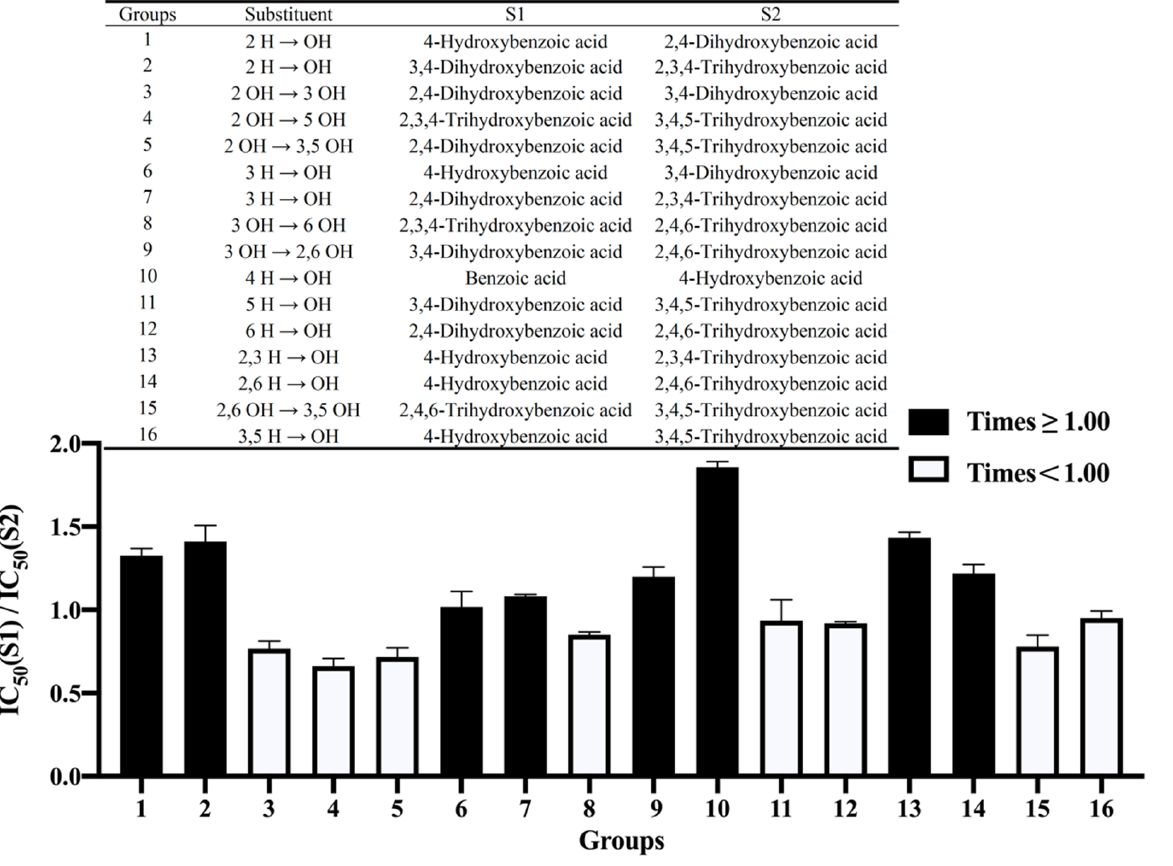
Figure 1. The effect of hydroxylation on the benzene ring on the inhibition of α -amylase by benzoic acid and its derivatives. S1—Structure 1; S2—Structure 2.